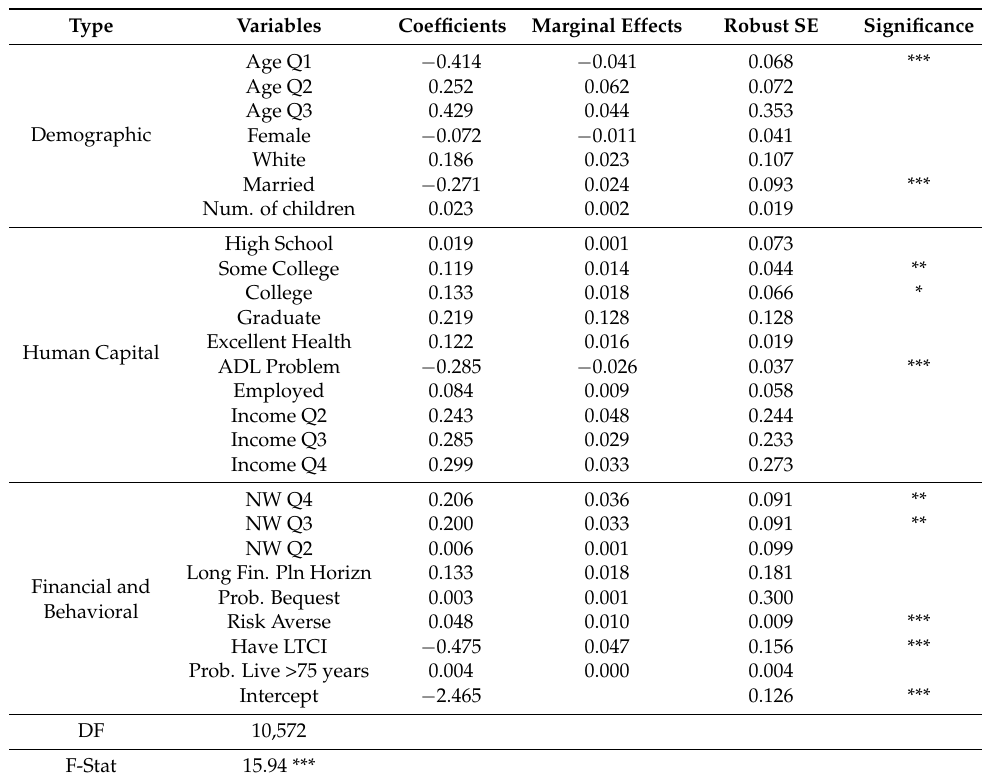
Table 2. Probit for having Reverse Mortgage